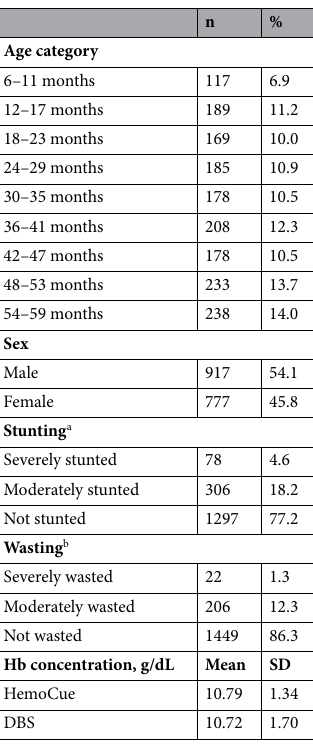
Table 2. Age, sex, and nutrition status of children 6–59 months (n = 1695). a Severely stunted: < − 3 HAZ; moderately stunted: − 3 to < − 2 HAZ; not stunted: ≥ − 2 HAZ. b Severely wasted: < − 3 WHZ; moderately wasted: − 3 to < − 2 WHZ; not wasted: ≥ − 2 WHZ.